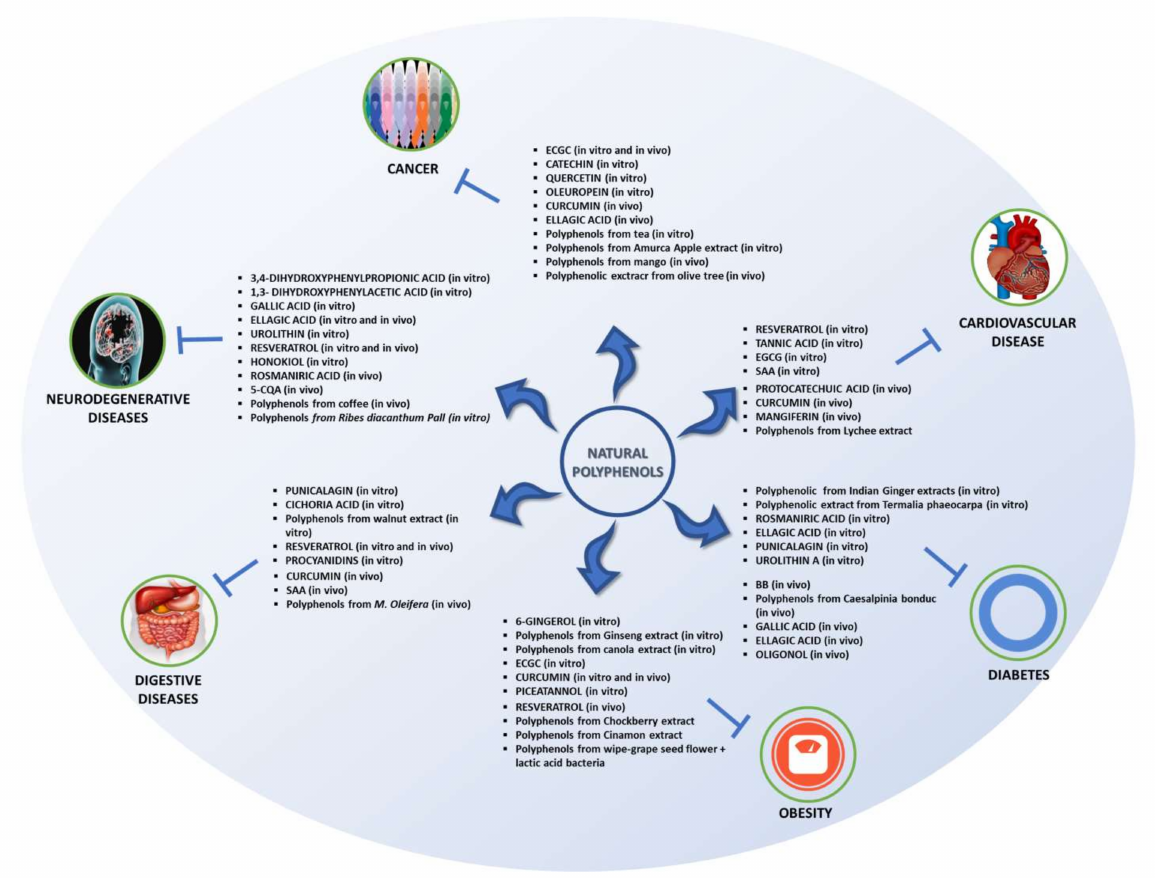
Figure 3. Effects of polyphenols found in animal models and in vitro